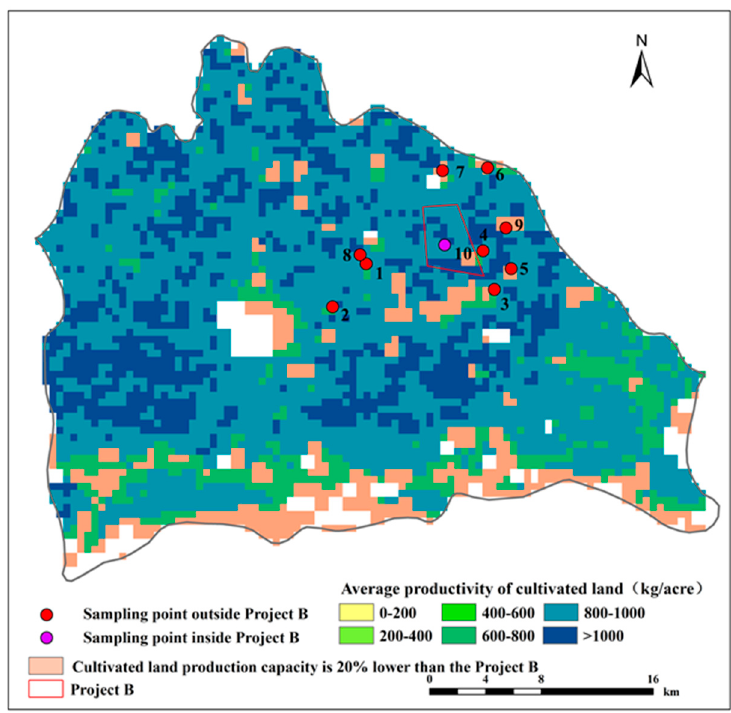
Figure 6. Distribution of sample points within and outside the HSF project region in the evalua- tion of productivity stability improvement (Project B as an